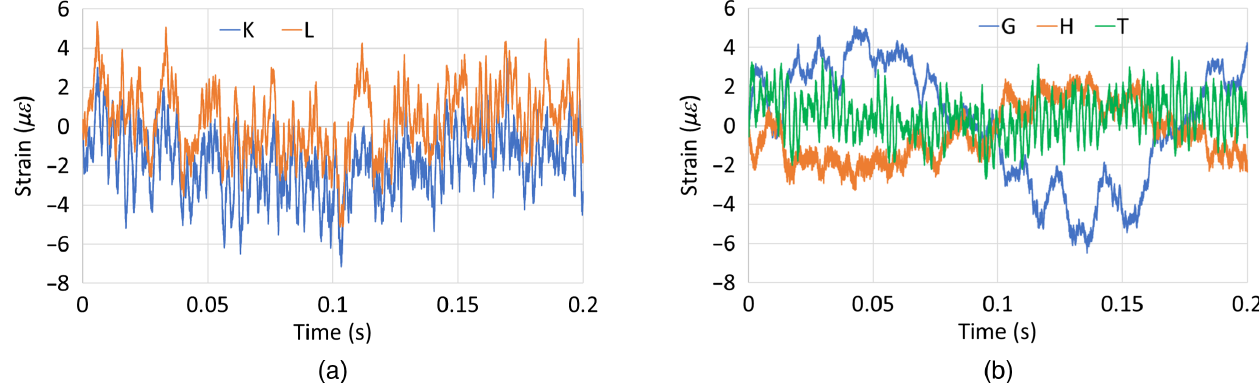
FIG. 27. Strain noise level from mercury flow at sensors K and L (a) and strain noise level from mercury flow at sensors G, H, and T (b).